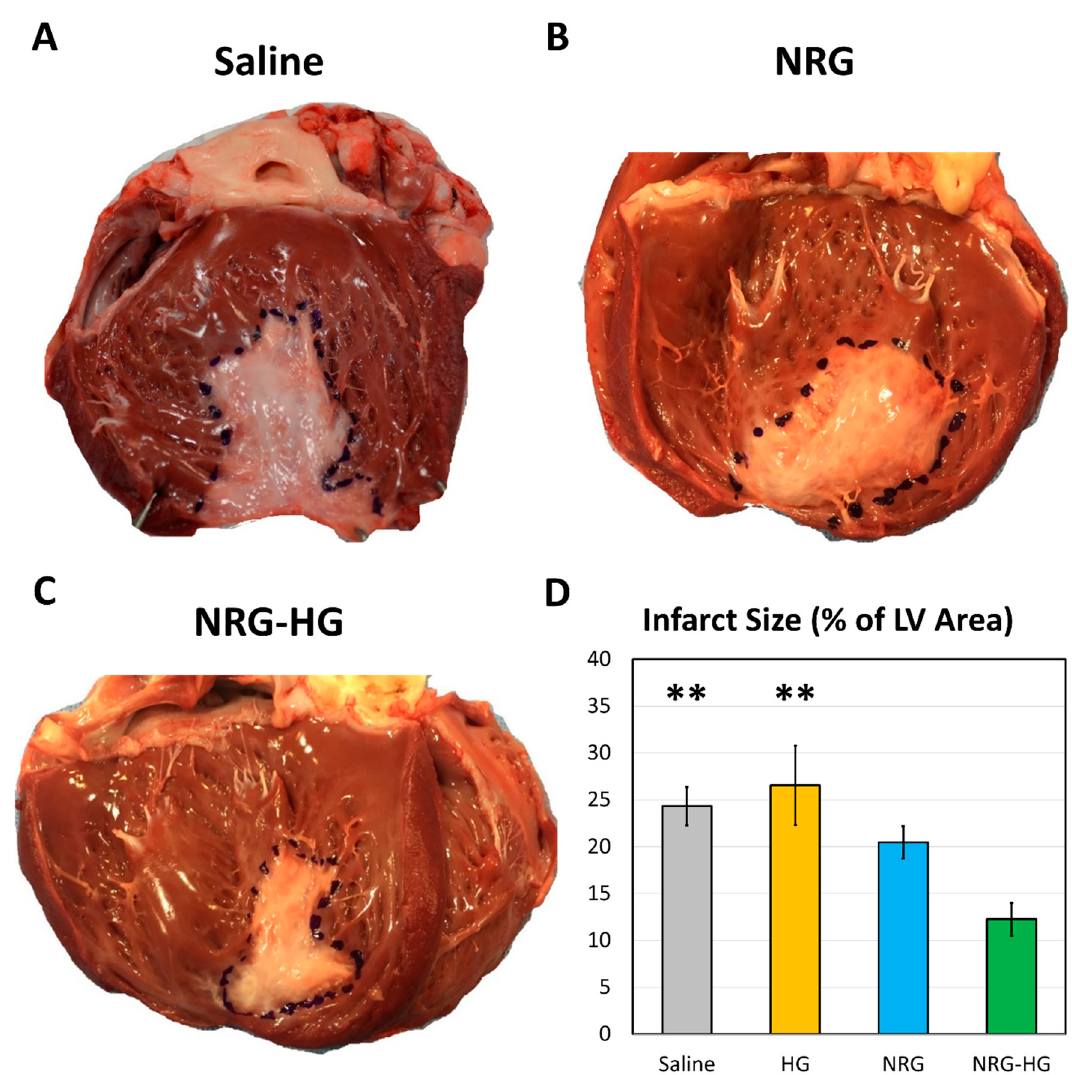
Figure 4. Left ventricular endocardial scar size at 8 weeks after myocardial infarction. Representative photographs of sheep hearts from the ( A ) saline, ( B ) neuregulin only (NRG), and ( C ) hydrogel-encapsulated neuregulin (NRG-HG) groups are shown. ( D ) Quantified scar size for the saline ( n = 6), hydrogel only (HG, n = 4), NRG only ( n = 4), and NRG-HG groups ( n = 7). Data are presented as mean ± standard error. ** indicates statistically significant ( p < 0.01) compared to the NRG-HG group.